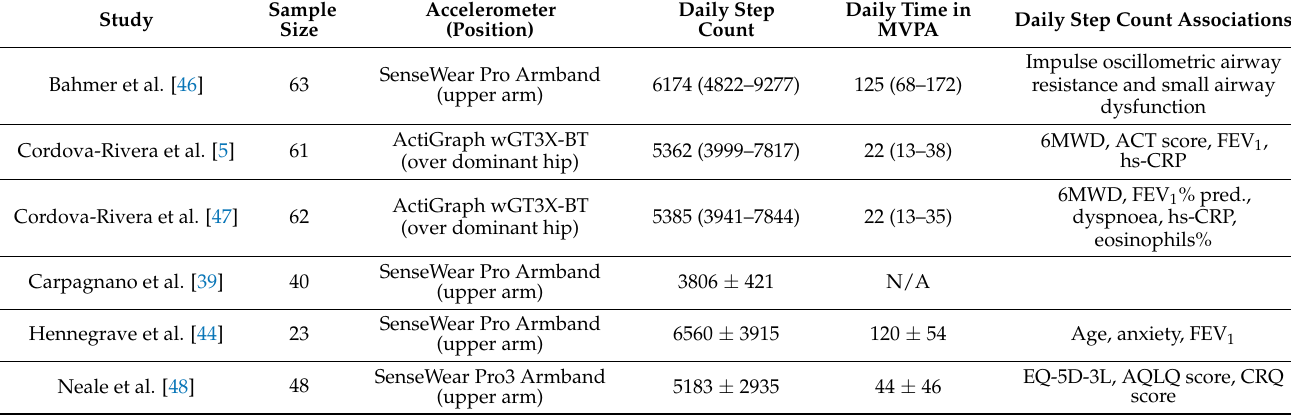
Table 3. Studies on daily physical activity in severe